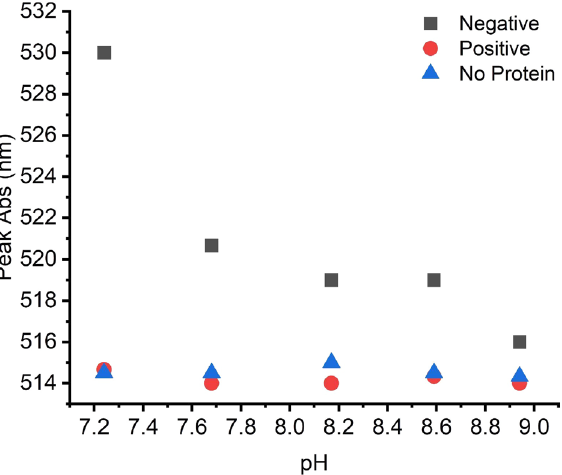
Figure 4. Wavelength of peak absorbance of AuNPs in varying pH buffers containing CWD negative rPrP (square), CWD positive (PrP CWD ) (circle), and blank/no protein (triangle)